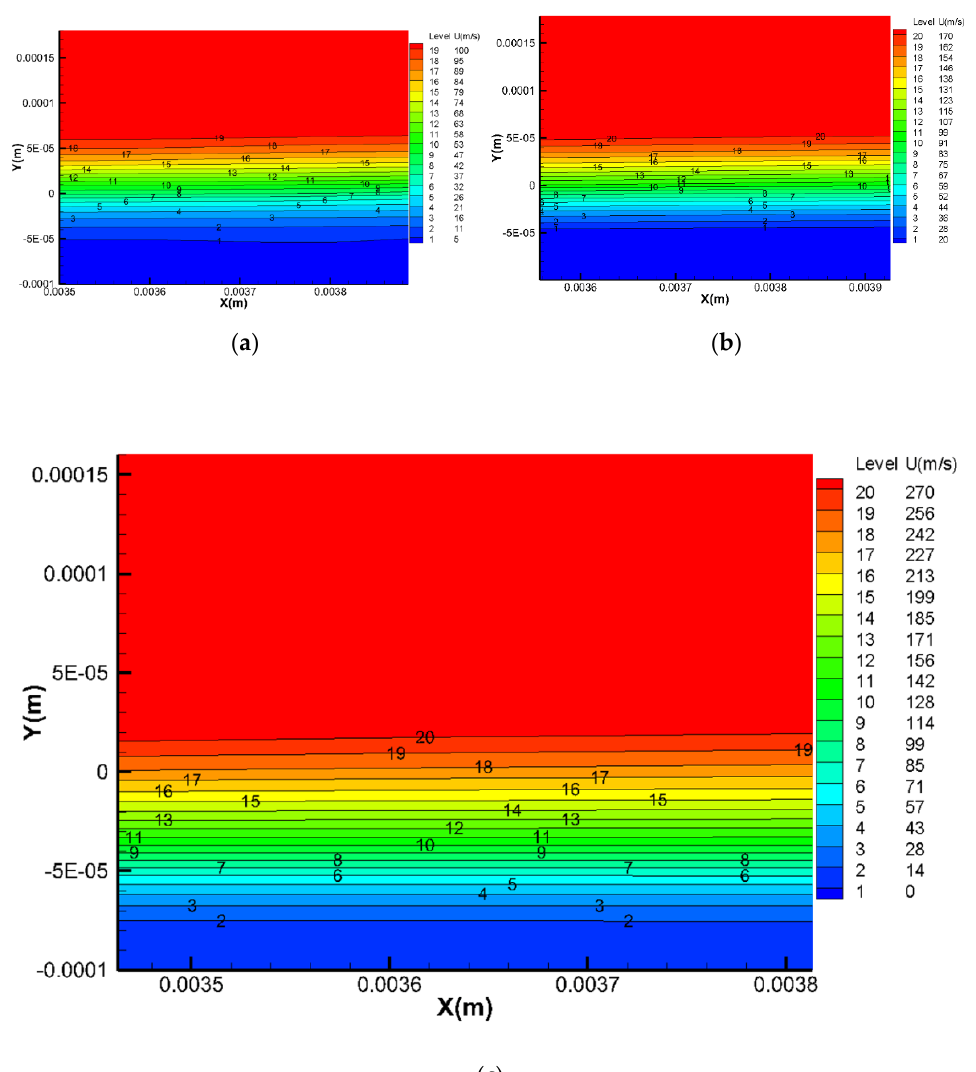
Figure 14. Spanwise plane velocity cloud picture of triangular groove plate under different Mach numbers; ( a ) 0.3 Ma; ( b ) 0.5 Ma; and ( c ) 0.8 Ma.